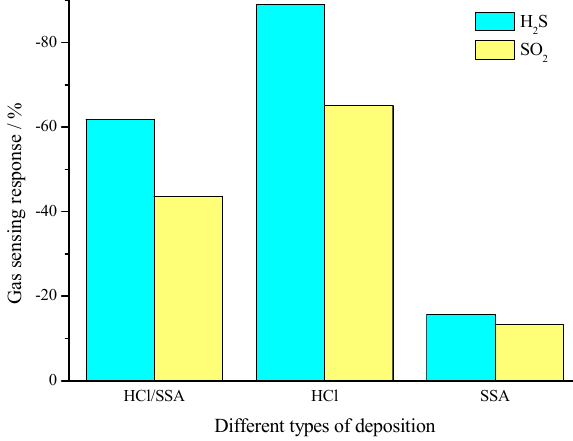
Figure 15. Gas-sensing sensitivity of PANI-HCl and PANI-HCl/SSA sensors to H 2 S and SO 2 of 100 μ L/L.